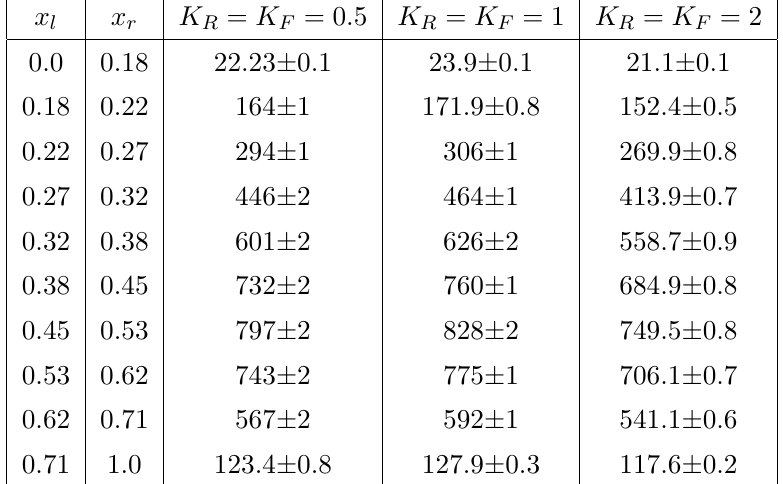
Table 5 . Same as table 3, but for µ 0 = H B